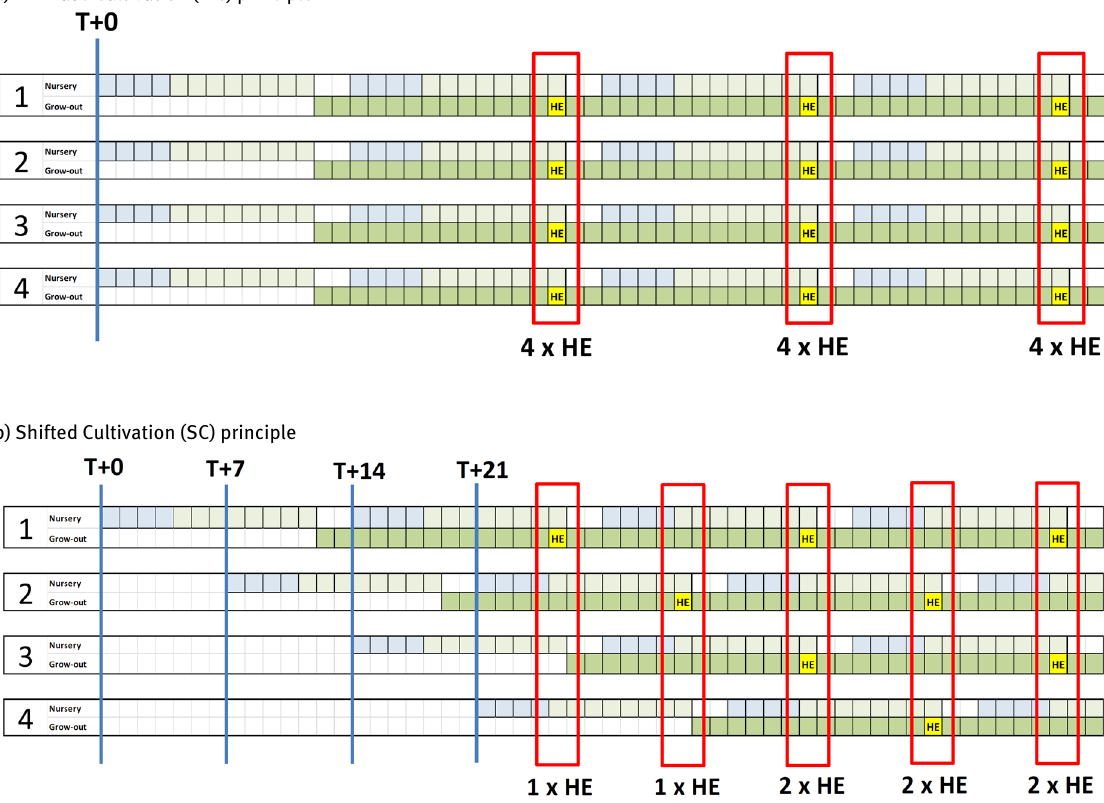
Figure 9: Overview of (a) In-Phase Cultivation (IPC) principle and (b) Shifted Cultivation (SC) principle. Shown are the four growth positions and the different starting points of the cultivation trays. For IPC, all trays start at the same time, resulting in the alignment of harvest events (HE); For SC, the trays are initiated sequentially so that the harvest events are also